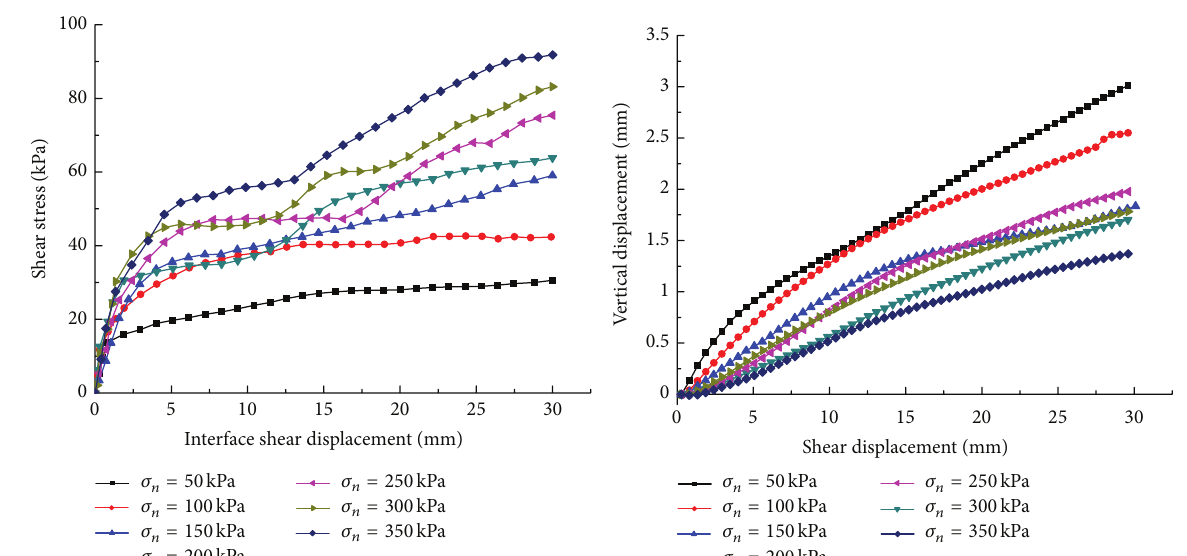
Figure 4: Test results for the interface between clay and #1 plate (initial normal stress of 400kPa).